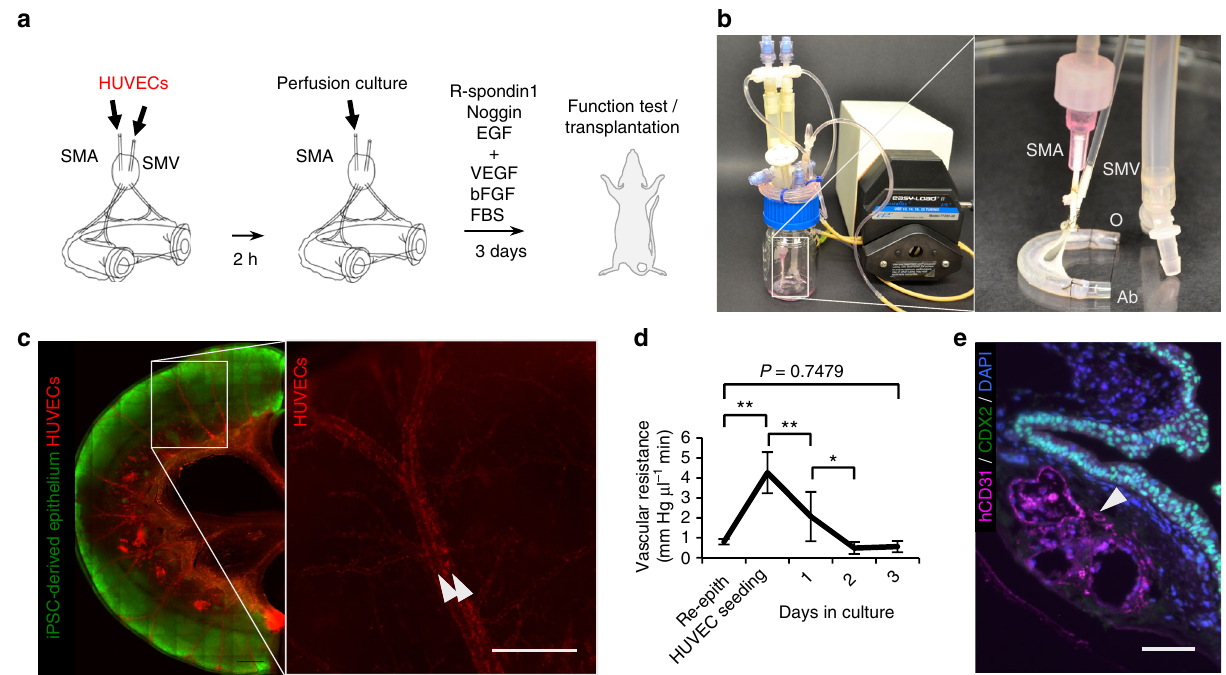
Fig. 3 Re-endothelialization of decellularized scaffold vasculature. a Method of human endothelial cell culture within the scaffold vasculature, using. 2 h of static culture followed by 3 days of arterial perfusion of culture prior to ex vivo function test or transplantation experiments. b Custom-built bioreactor allowing for endothelial cell deliveries to scaffold artery and vein, and subsequent perfusion culture. c Whole-mount fl uorescence micrographs of a scaffold following 14 days of iPSC-derived epithelial cell culture and subsequent seeding with RFP-labeled HUVECs for an additional day. HUVECs distributed throughout the arterial and venous vascular systems ( white arrowheads ) with minimal leakage. Scale bar , 1 mm. d Vascular resistance of re-endothelialized intestinal scaffolds ( n = 3) under constant rate perfusion. e Intestinal epithelium (CDX2 + ) and endothelium (CD31 + ) engrafted on an intestinal scaffold after 17 days culture in vitro. An open capillary vessel ( white arrowhead ) is seen between an artery and a vein. Scale bar , 100 µ m. Error bars , mean ± s.d. of experimental values. * P < 0.05; ** P < 0.01, Student ’ s t test. Ab, aboral end; O, oral end of